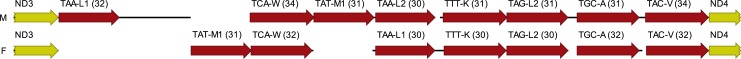
Alignment of a fragment of F and M mitogenomes located between nd3 and nd4.This part of mitogenomes contain several trn genes. They are labeled with their anticodon and amino acid one letter code. Additionally, trn genes of the same amino acid specificity are numbered consecutively, along the genome (as in Fig. 1). All the trn genes presented here were predicted with high confidence by ARWEN. The bitscore for each gene prediction is shown in bracket. The L1 gene of the F mitogenome is aligned with the L2 gene of the M mitogenome while the positions of M1 and W are switched.